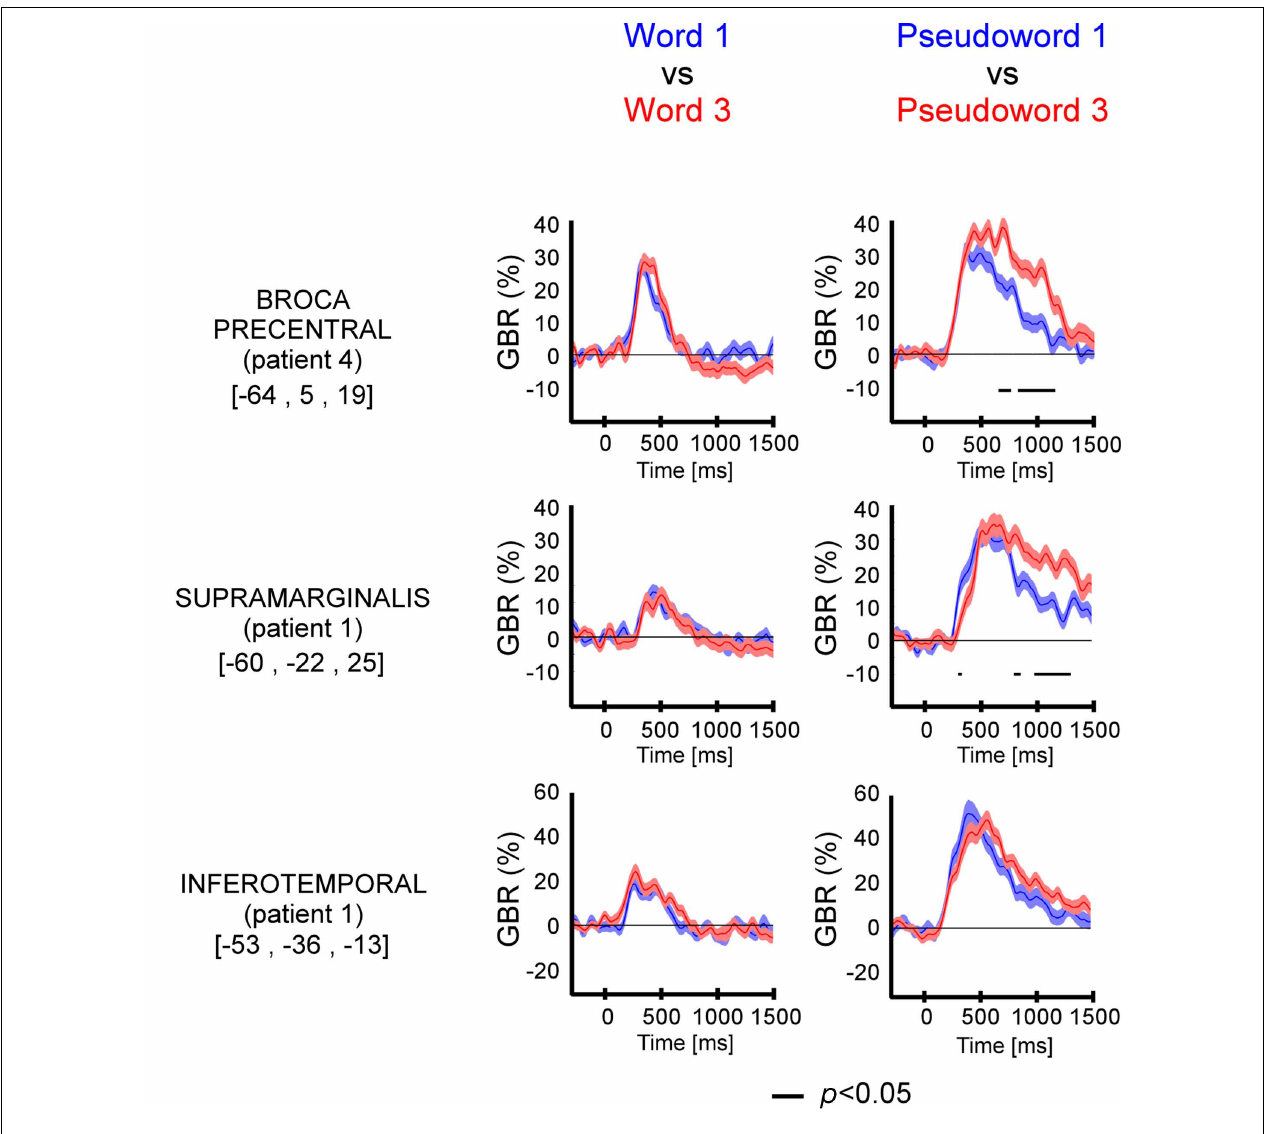
corrected for multiple comparisons). Length (long vs. short) shows significant effect only for pseudo-words in Broca’s and SMG. No effect of length has been observed for words. For each region theTalairach coordinates are mentioned.